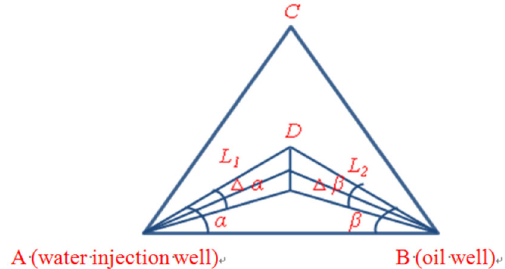
Fig. 11 Computing unit of the five-spot